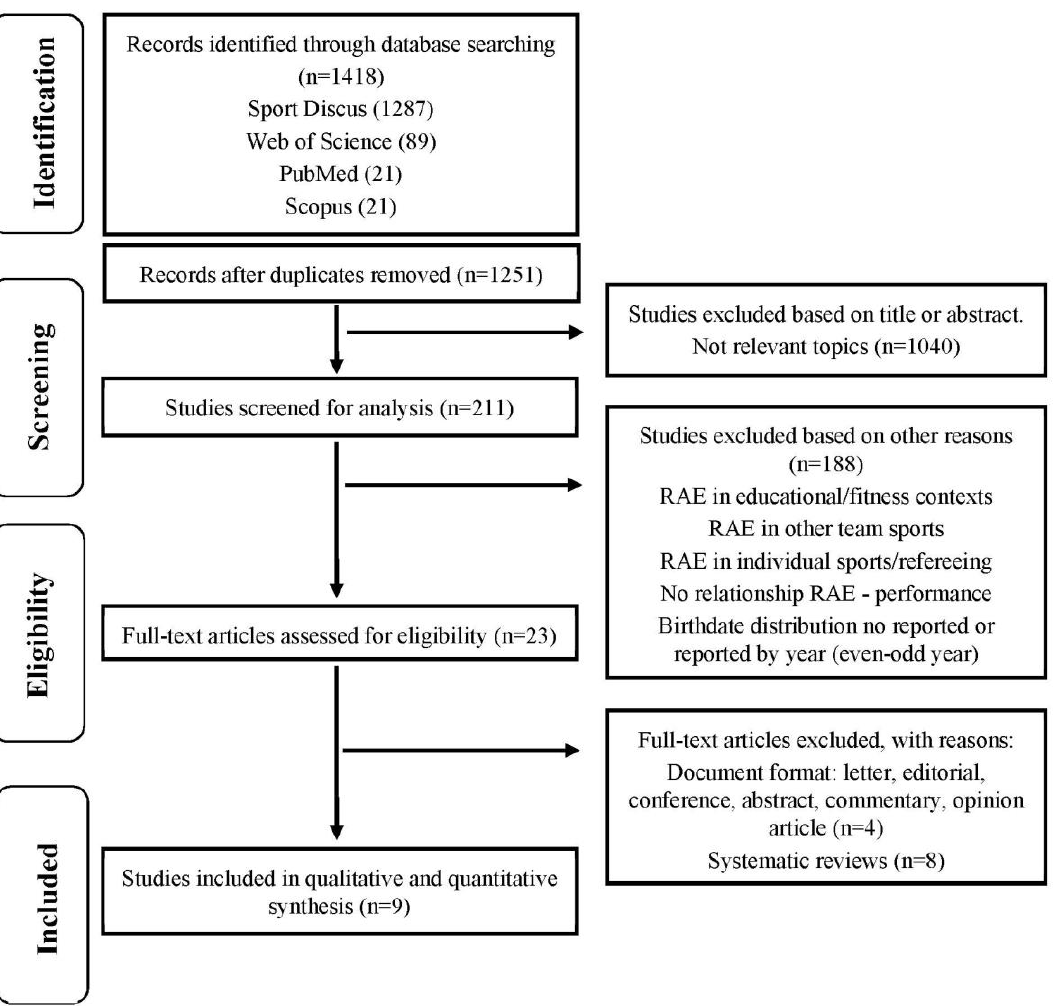
Figure 1. Flow diagram for screening and selection of studies according to Preferred Reporting Items for Systematic Reviews and Meta-Analysis (PRISMA).